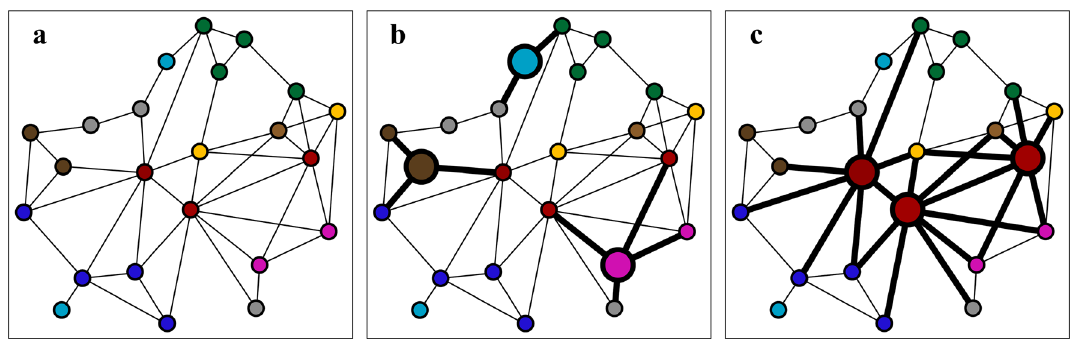
Figure 1. Vaccination campaign scenarios. ( a ) Baseline scenario without vaccinations, ( b ) random distribution of vaccines, and ( c ) targeted distribution of vaccines based on occupational group membership in descending order of average number of social contacts. Nodes represent individuals and colors represent occupational group membership (e.g., red: Healthcare Practitioners and Technical Occupations with high average degree, brown nodes: Office and Administrative Support Occupations with low average degree). Enlarged nodes represent immunized individuals. Thick ties represent social connections of immunized nodes, and are therefore ruled out as possible transmission